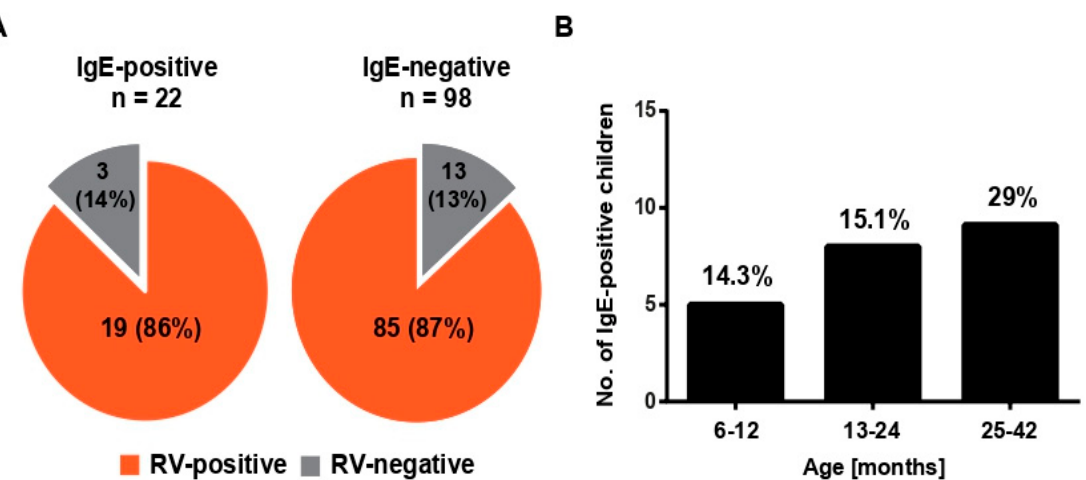
Figure 4. Allergen-specific IgE responses in preschool children presenting with acute wheeze. ( A ) Percentages of wheezing children with and without increases in RV-specific IgG among IgE-sensitized ( n = 22, left) and non-sensitized ( n = 98, right) children; ( B ) numbers ( y -axis) and percentages of IgE-sensitized children in the three age groups.